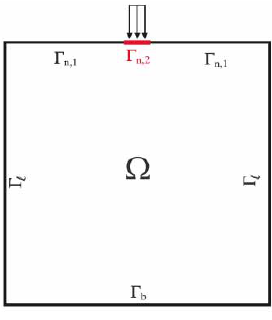
Figure 2. Computational domain for the footing